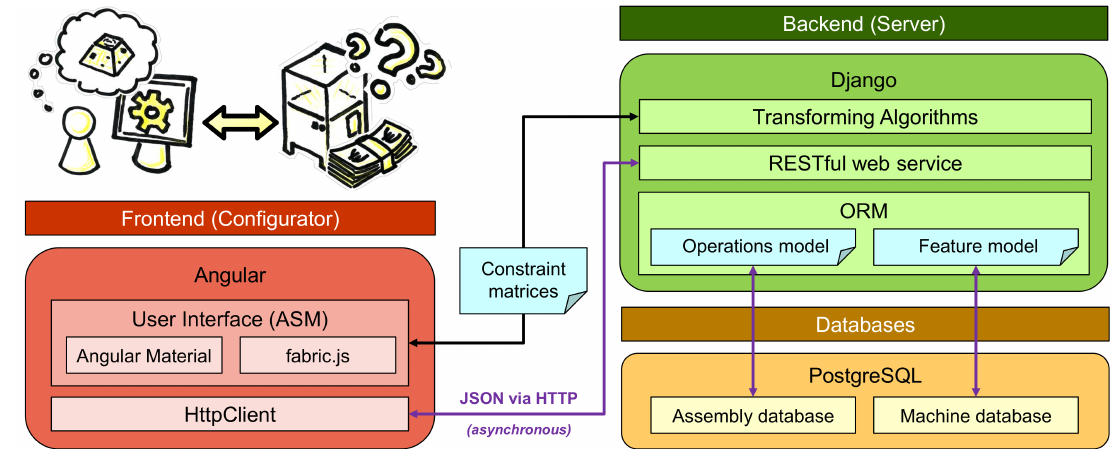
Figure 8. Overview of the whole software architecture of